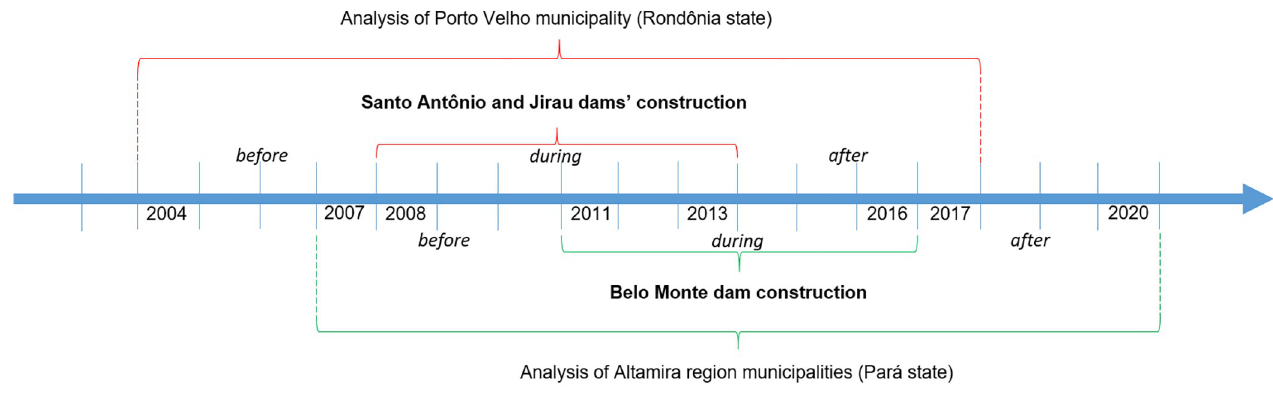
Fig 2. Time scale for the analysis of malaria in Velho municipality (PVH) and Altamira region municipalities (ATM), 2004–2017 and 2007–2020, respectively. Source: Elaborated by the authors.